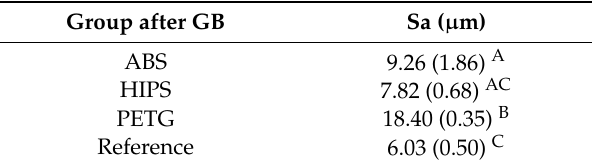
Figure 7. Sa values of all material groups before and after GB (Mean ± SD, n = 3). * represents statistically significant differences in Sa of all groups before and after GB. Table 2. Mean (standard deviation) Sa value of each group after GB. The results of statistical analysis were shown by superscript letters. The groups with the same superscript letter had no statistical difference.